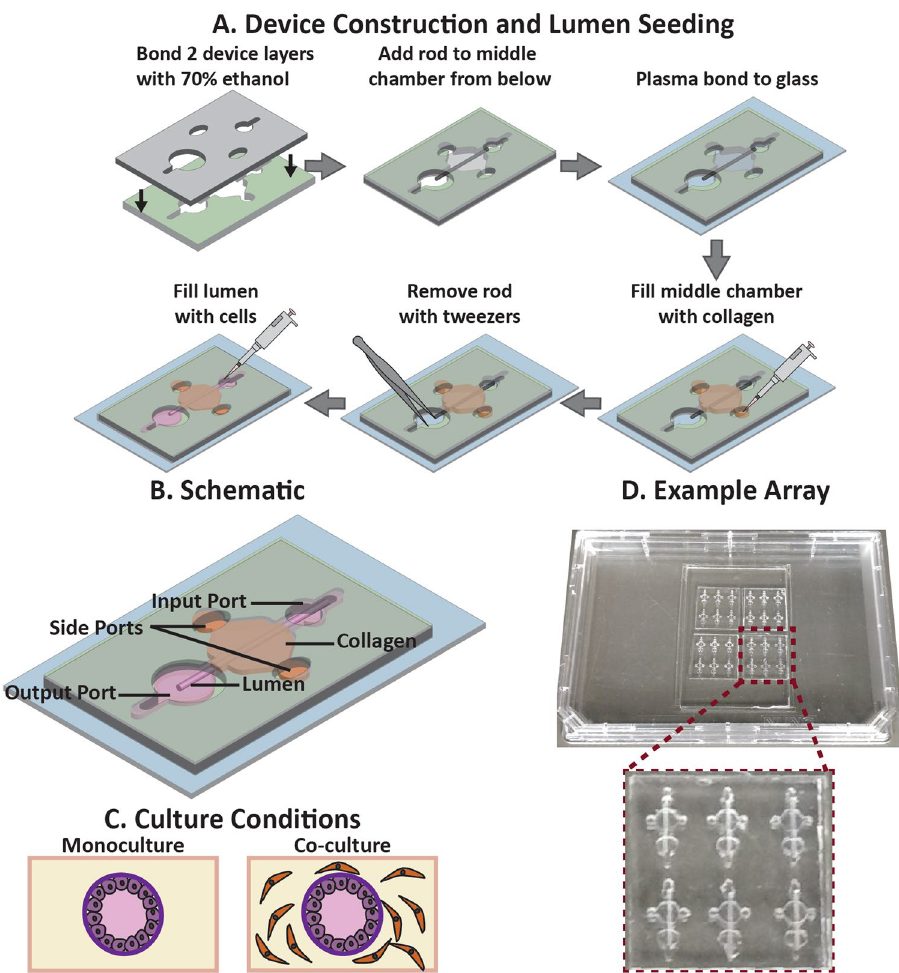
Figure 1. Device illustration and culture conditions. ( A ) The LumeNEXT method 49 was used to create the two-layered microfluidic devices. ( A ) depicts device construction and use, and ( B ) shows a detailed device schematic. ( C ) The platform allows the investigation of stromal cells on duct function and estrogenic response, as the duct can be cultured in a collagen matrix, as well as cultured in a collagen matrix that has stromal cells embedded throughout. An example of a device array is shown in ( D ), where 24 devices are plasma bonded to a cover slip attached to an omni tray.